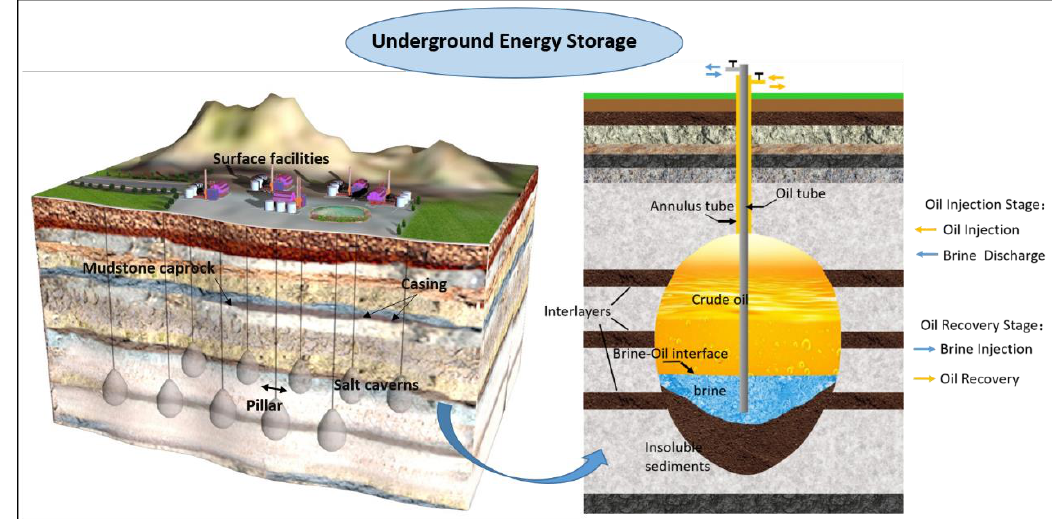
Figure 2. The process of crude oil injection – production of SPR in rock salt.